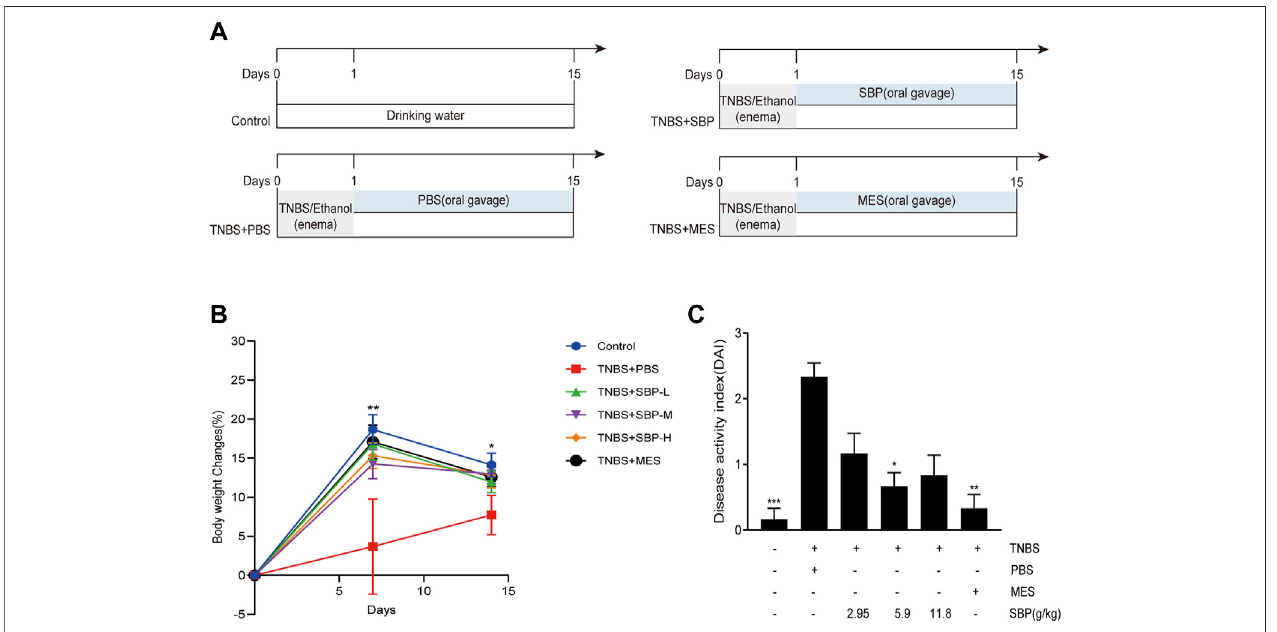
FIGURE1| SBPinterventionamelioratedtheclinicalsignalsinratswithexperimentcolitis. (A) Schematicdiagramoftheexperimentaldesign. (B) Percentageofthe bodyweightchange. (C) Diseaseactivityindex(DAI).Datashownasmeans±SEM, n =6rats/group.vs.TNBS+PBSgroup,* p < 0.05,** p < 0.01.SBP-L,low-doseSBP group (2.95 g/kg); SBP-M, medium-dose SBP group (5.9 g/kg); SBP-H, high-dose SBP group (11.8